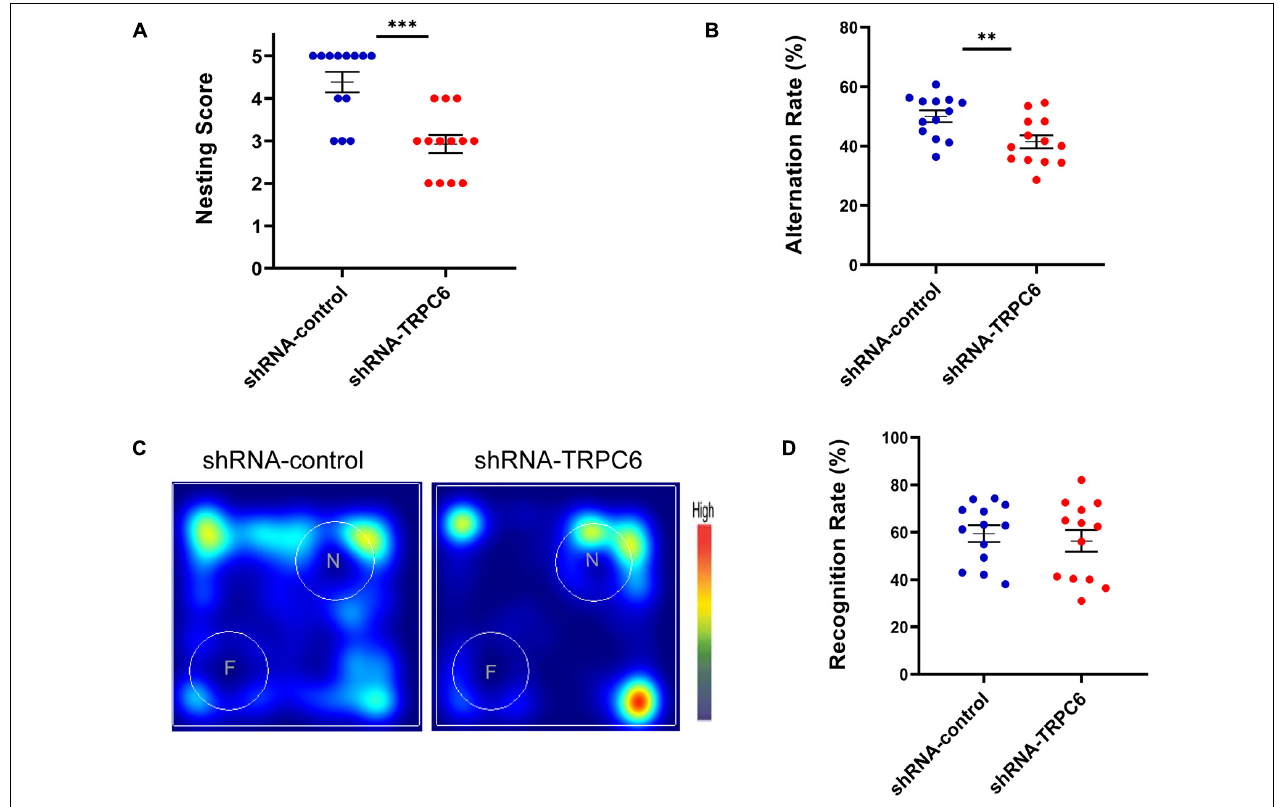
FIGURE 3 | shRNA-TRPC6 injection affected hippocampal related-memory in mice. (A) shRNA-TRPC6 injected mice displayed impaired nest building abilities (*** p < 0.001, t -test). (B) Scatter plot showing the percentage of correct spontaneous changes in both groups (** p < 0.01, t -test). (C) Representative heat maps showing the duration of time that the mice spent exploring the objects in NOR test. “F” and “N” represent the familiar object and the novel object, respectively. (D) There was no significant difference in recognition rate between the two groups. ( p = 0.603; t -test). Sample sizes for each group: n = 13. Data were presented as mean ±